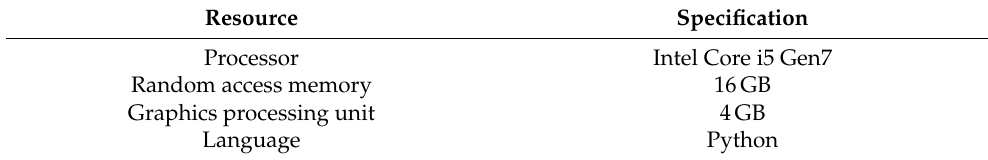
Table 3. Experimental setup details.